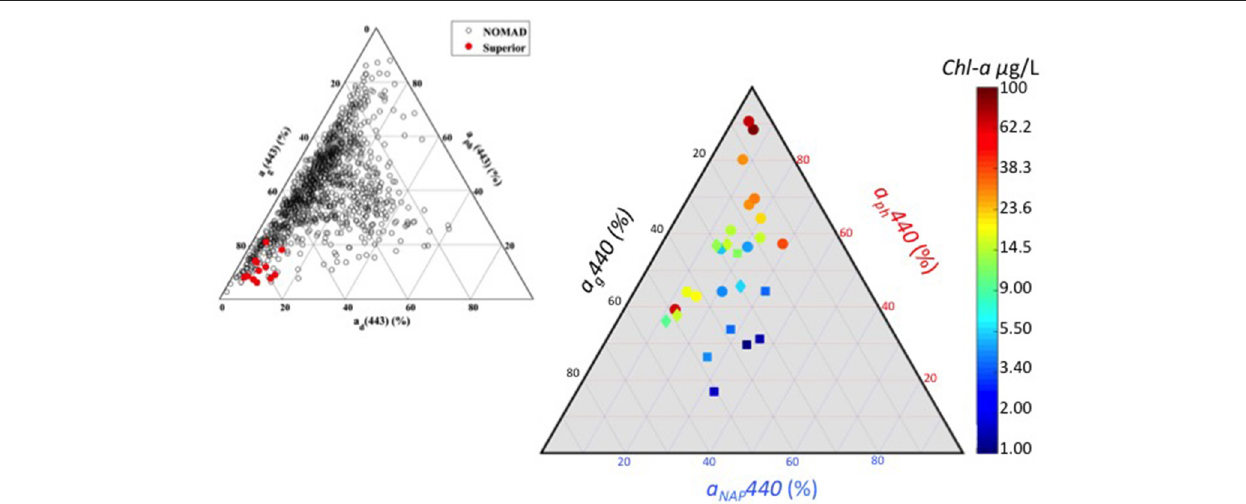
FIGURE 4 | (Right) Ternary plot of absorption color-coded by chlorophyll-a concentration. Symbols indicate region: square Detroit River plume (DR); diamond central basin (CB); circle Maumee Bay waters (MB). (Left) Ternary plot from Mouw et al. (2013a) (their Figure 3) showing absorption properties for Lake Superior (red) and the global oceans from NOMAD (black). Figure inset is being reproduced with permission from the copyright